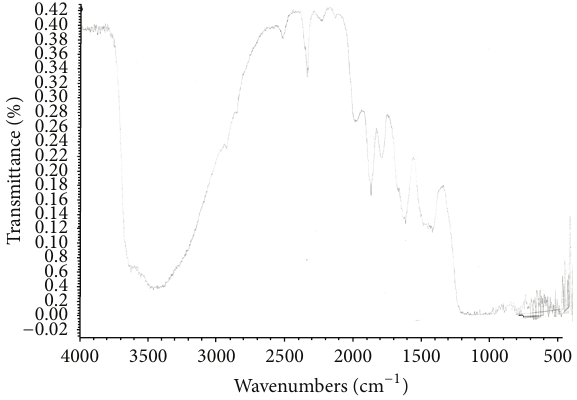
Figure 1: FTIR spectrum of kaolin clay before acid leaching.